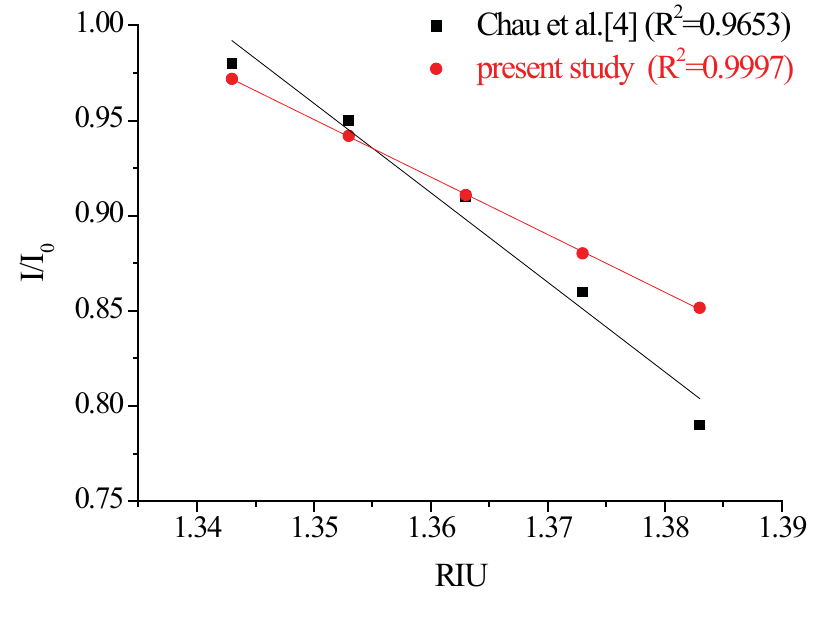
Figure 25. Plot of the sensor response versus the refractive index of the sucrose